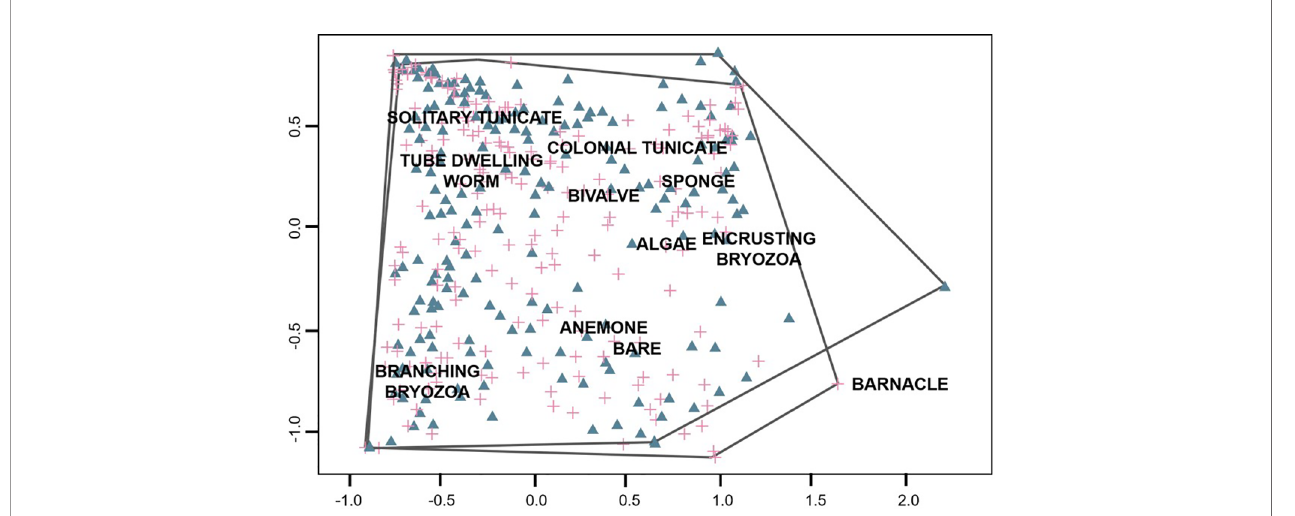
FIGURE 5 | NMDS plot of community measurements taken by volunteers and scientists (enclosures). Panel measurements are represented in triangles (volunteers) and crosses (scientists).